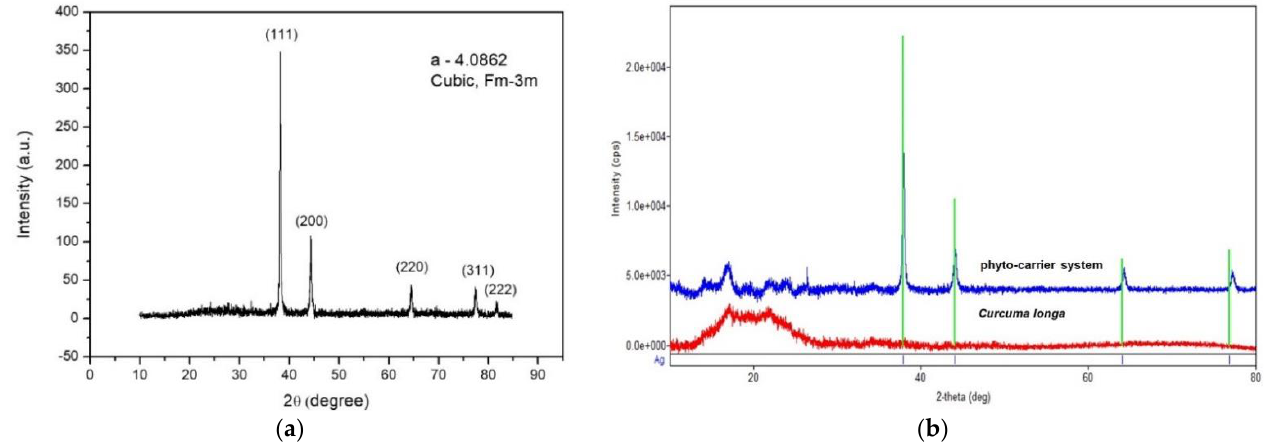
Figure 7. ( a ) Powder XRD patterns of AgNPs; ( b ) XRD patterns of curcuma and the phytocarrier system.